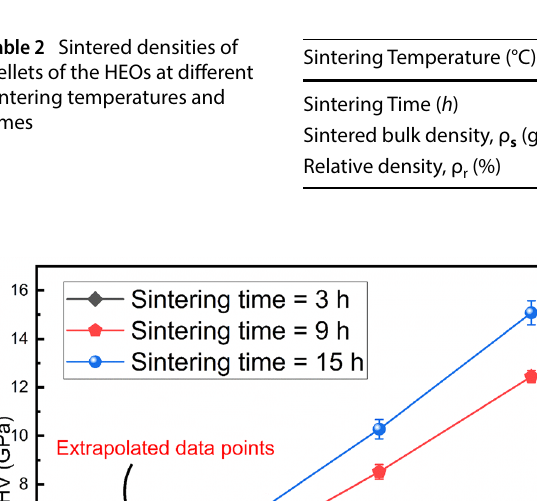
Fig. 8 SEM micrographs of HEO samples sintered at 1100 °C with sintering time of ( a ) 3 h and ( b ) 15 h